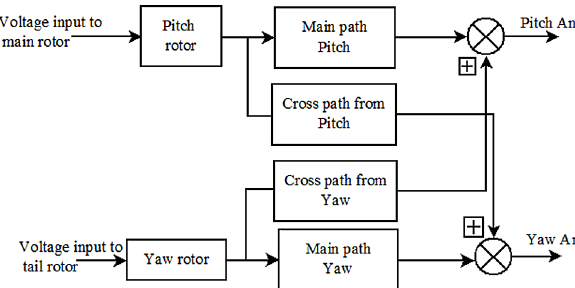
Figure 1. Block diagram of basic twin-rotor multi-input multi-output